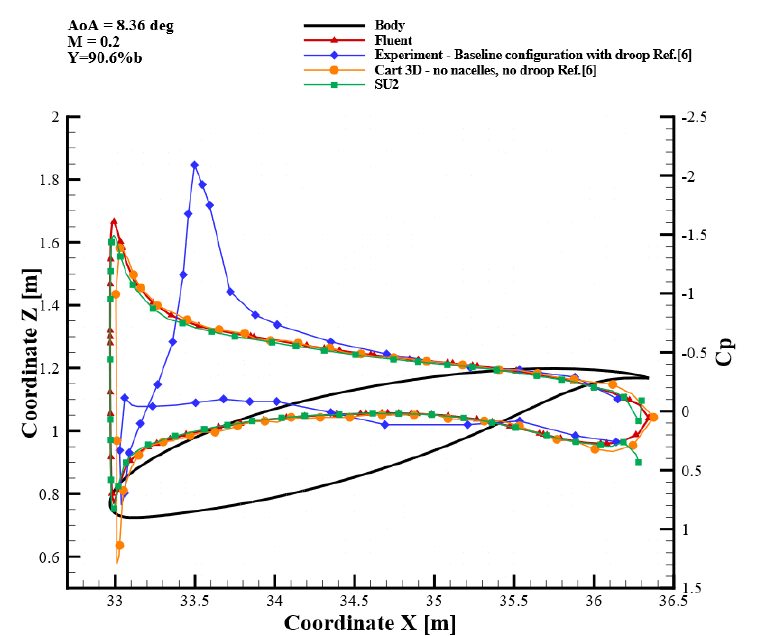
Figure 19. Chordwise pressure distribution at β = 90.6%, comparison between present results and literature data.